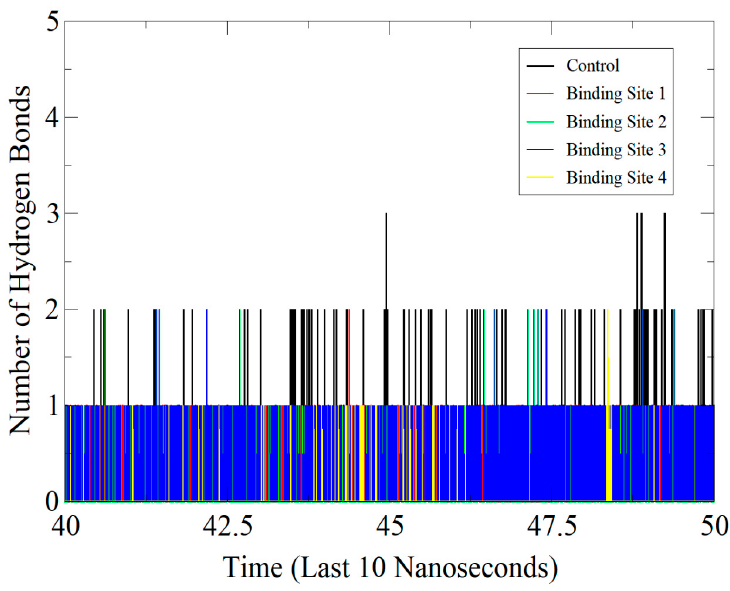
Figure 8. Hydrogen bond analysis for control/hit complexes in the last 10 ns of MD simulation trajectories.